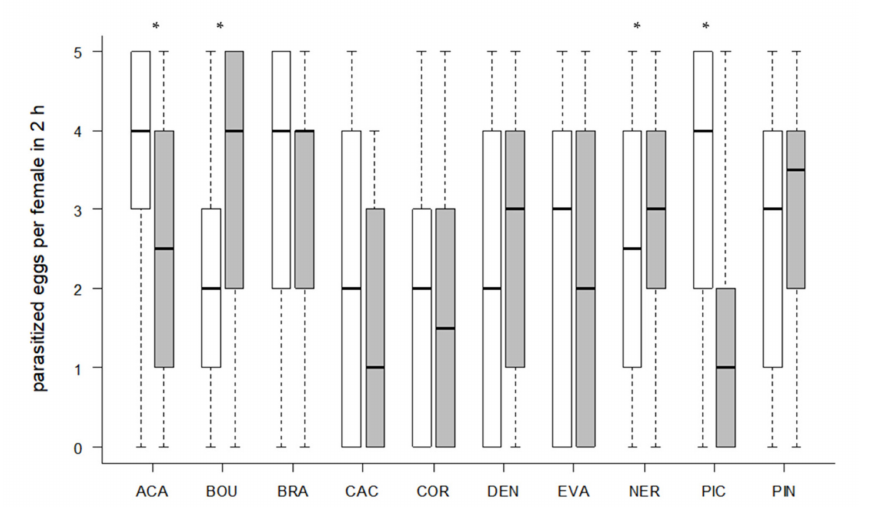
Figure 5. Number of parasitized eggs per parasitoid female. Five eggs of the rearing host S. cerealella (white) and five T. absoluta eggs (grey) were o ff ered to each female simultaneously in a choice-test for two hours. Box plots denote median (solid line) and whiskers show range of data. Asterisks indicate significant di ff erences within one Trichogramma strain ( p < 0.05, n = 30 females per